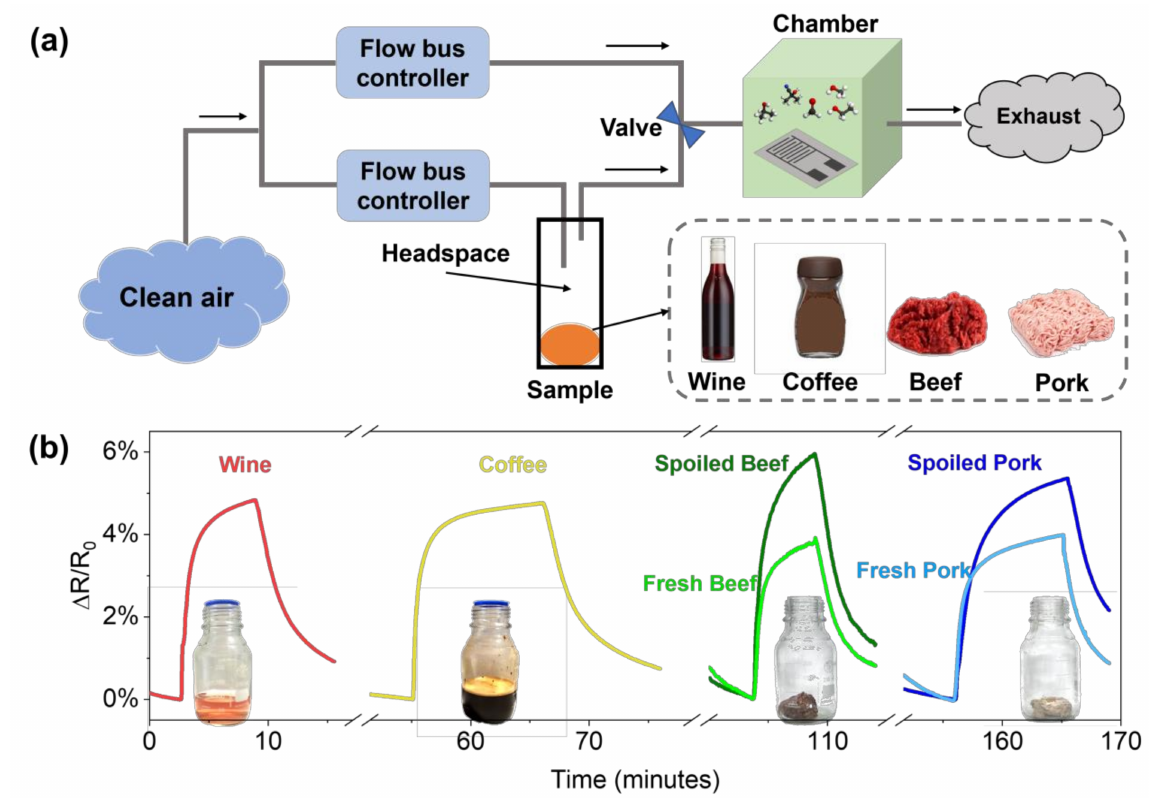
Figure 8. ( a ) Schematic representation of the total VOC measurement system for real samples; ( b ) the responses of the PDAC/rGO sensor to VOCs from beverage and meat